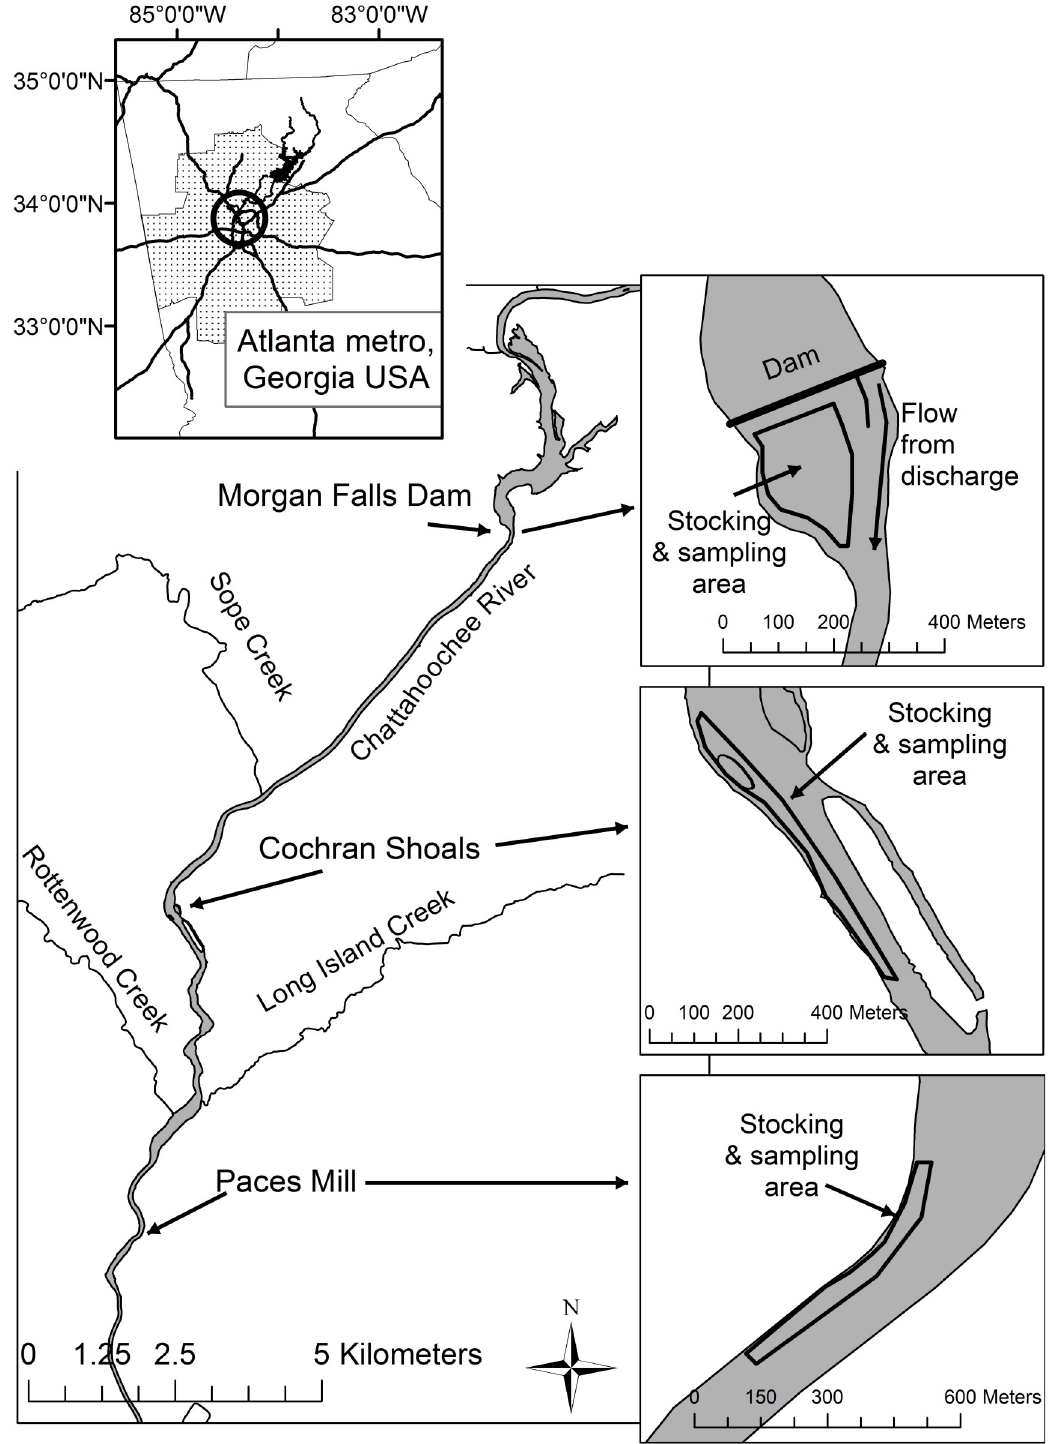
Fig 1. Map of the upper Chattahoochee River below Morgan Falls Dam. Juvenile Shoal Bass were stocked at three sites in the river in May and June 2004. Juvenile Shoal Bass were collected at these three sites in June and August 2004.